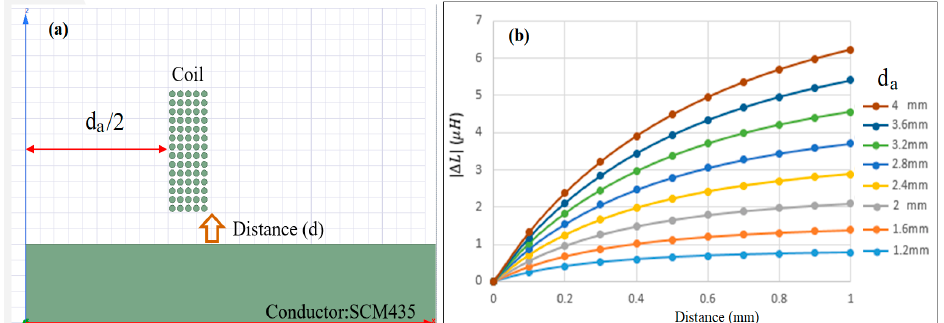
Figure 3. ( a ) Coil winding arrangement with 5 layers, and ( b ) effect of inner coil diameter on in-